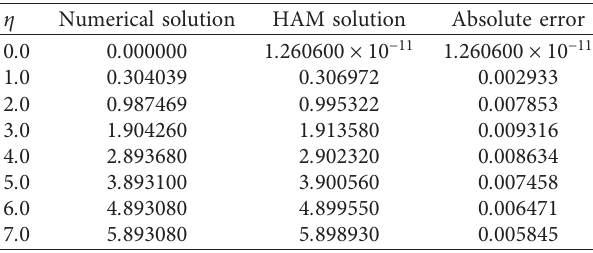
Figure 5: Graphical comparison for two solutions in case of the concentration profile. Table 1: Numerical solution via the analytical solution for the velocity f ′ ( η ) profile.